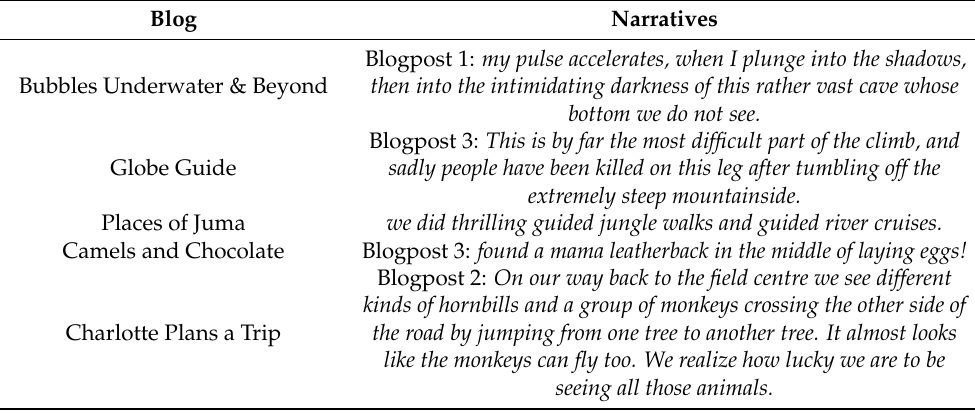
Table 4. Emotional Narratives on Theme